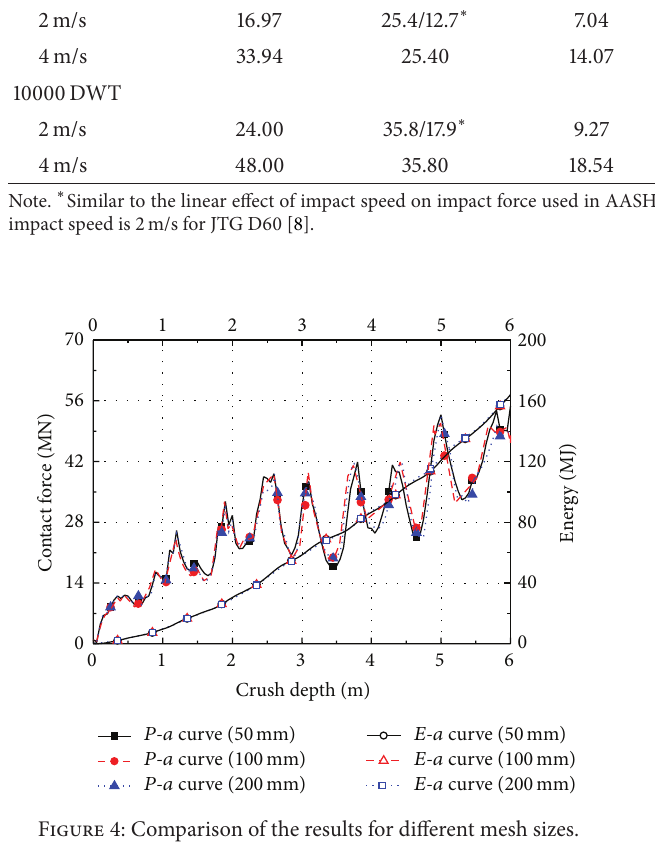
of the observed results; 𝑁 is the number of observations.